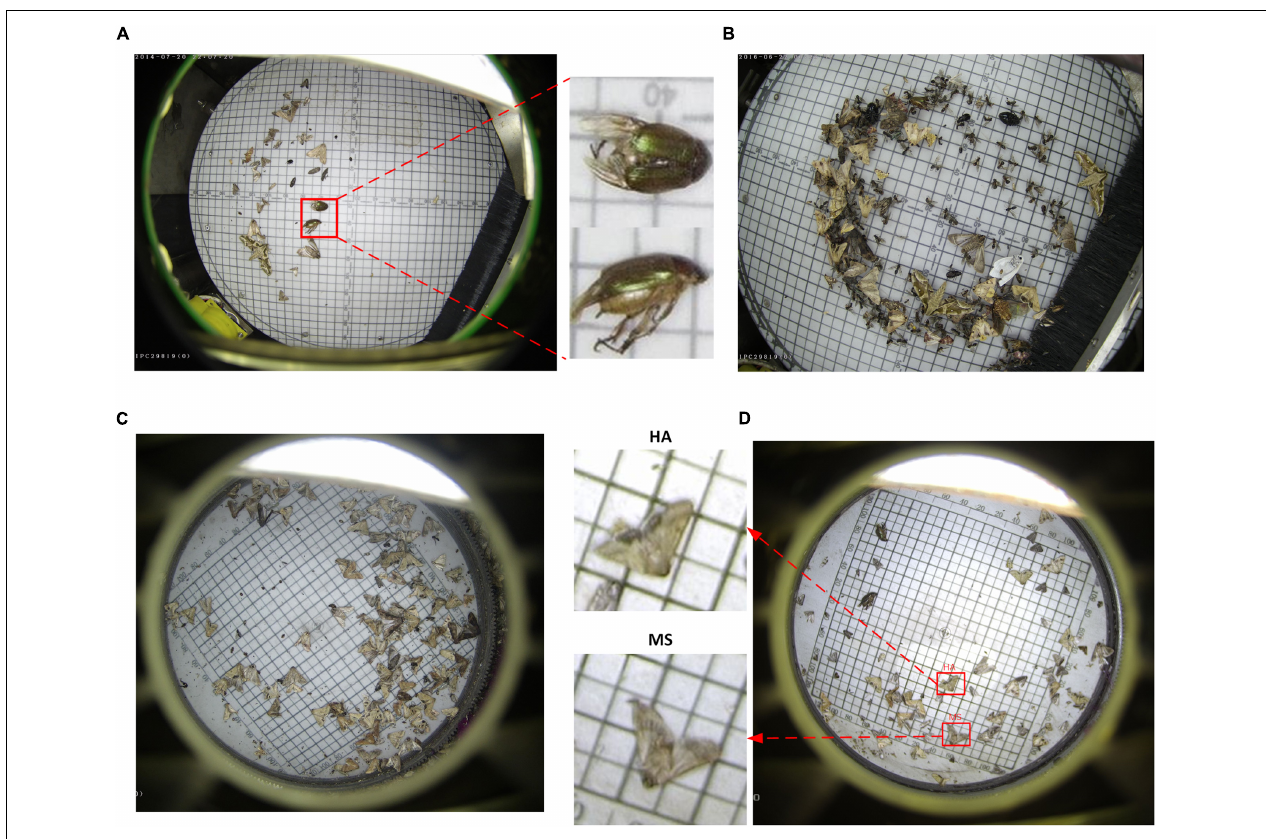
FIGURE 2 | Some examples of agricultural pest images. (A) Different shapes of the same class of pests. (B) Serious overlap. (C) Dense distribution. (D) High similarity between the classes “HA” and “MS.”